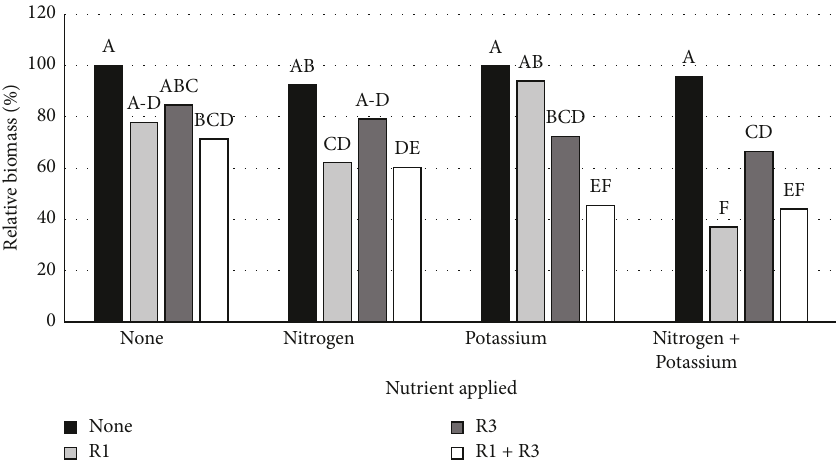
Figure 4: Relative biomass of soybean according to the interaction of application timing and fertilizer type for the experiment conducted in Fayetteville, AR, in 2019 and 2020. Treatments with the same uppercase letter are not significantly different according to Fisher’s protected least significant difference α (cid:29)